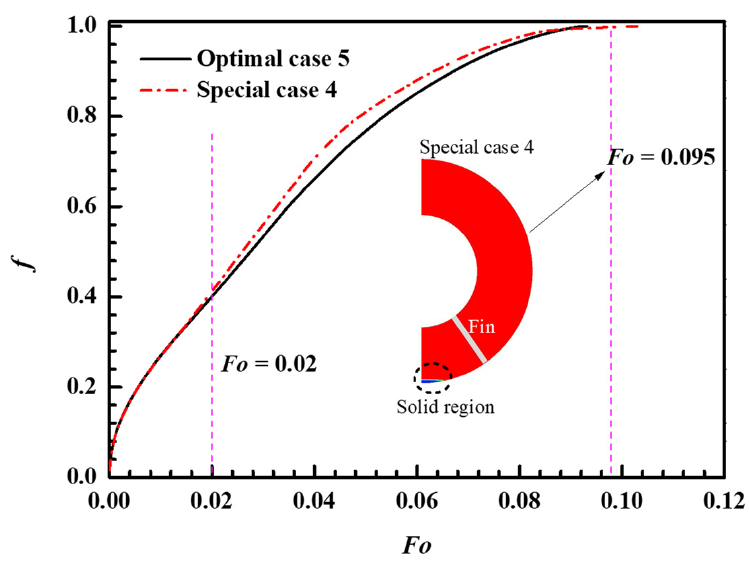
Figure 11. Variation of the liquid fraction, f , with dimensionless melting time, Fo , for Optimal Case 5 and Special Case 4.